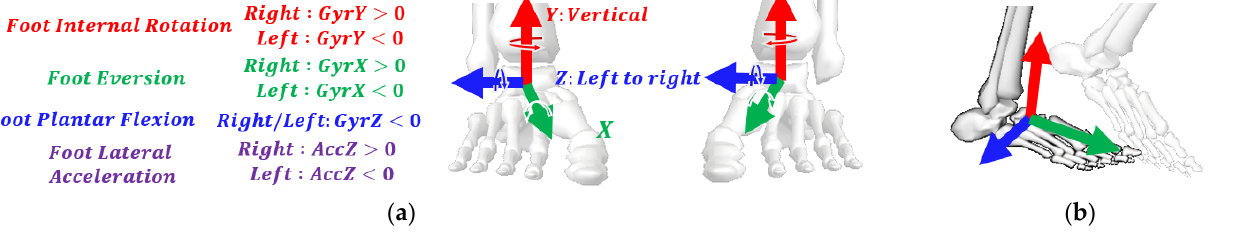
Figure 3. ( a ) Anatomical frame of the foot: with the Y -axis aligned with the gravity in the foot flat period, the Z -axis aligned with the plantar/dorsal flexion with direction from left to right, and the X -axis formed by the external cross of the Y and Z. In this frame, the plantar flexion of both feet is reflected as negative signals in Gyr z . However, the internal rotation and eversion of the right foot led to positive signals in Gyr y and Gyr x , respectively, while negative on the left side. ( b ) Foot clears the ground by rotating negatively around the Z-axis in almost all pathologic patterns.